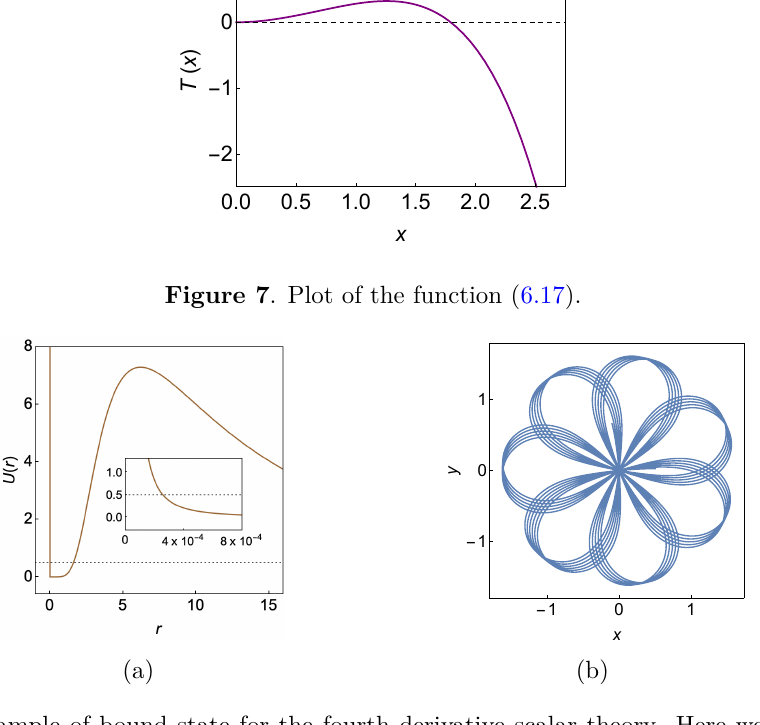
Figure 8 . Example of bound state for the fourth derivative scalar theory. Here we set g = 100 , µ = 1 , ω = 2 , a = 1 , b = 0 . 05 and evolved the system till the final time t f = 150 . (a) Effective potential. (b) The trajectory in the xy